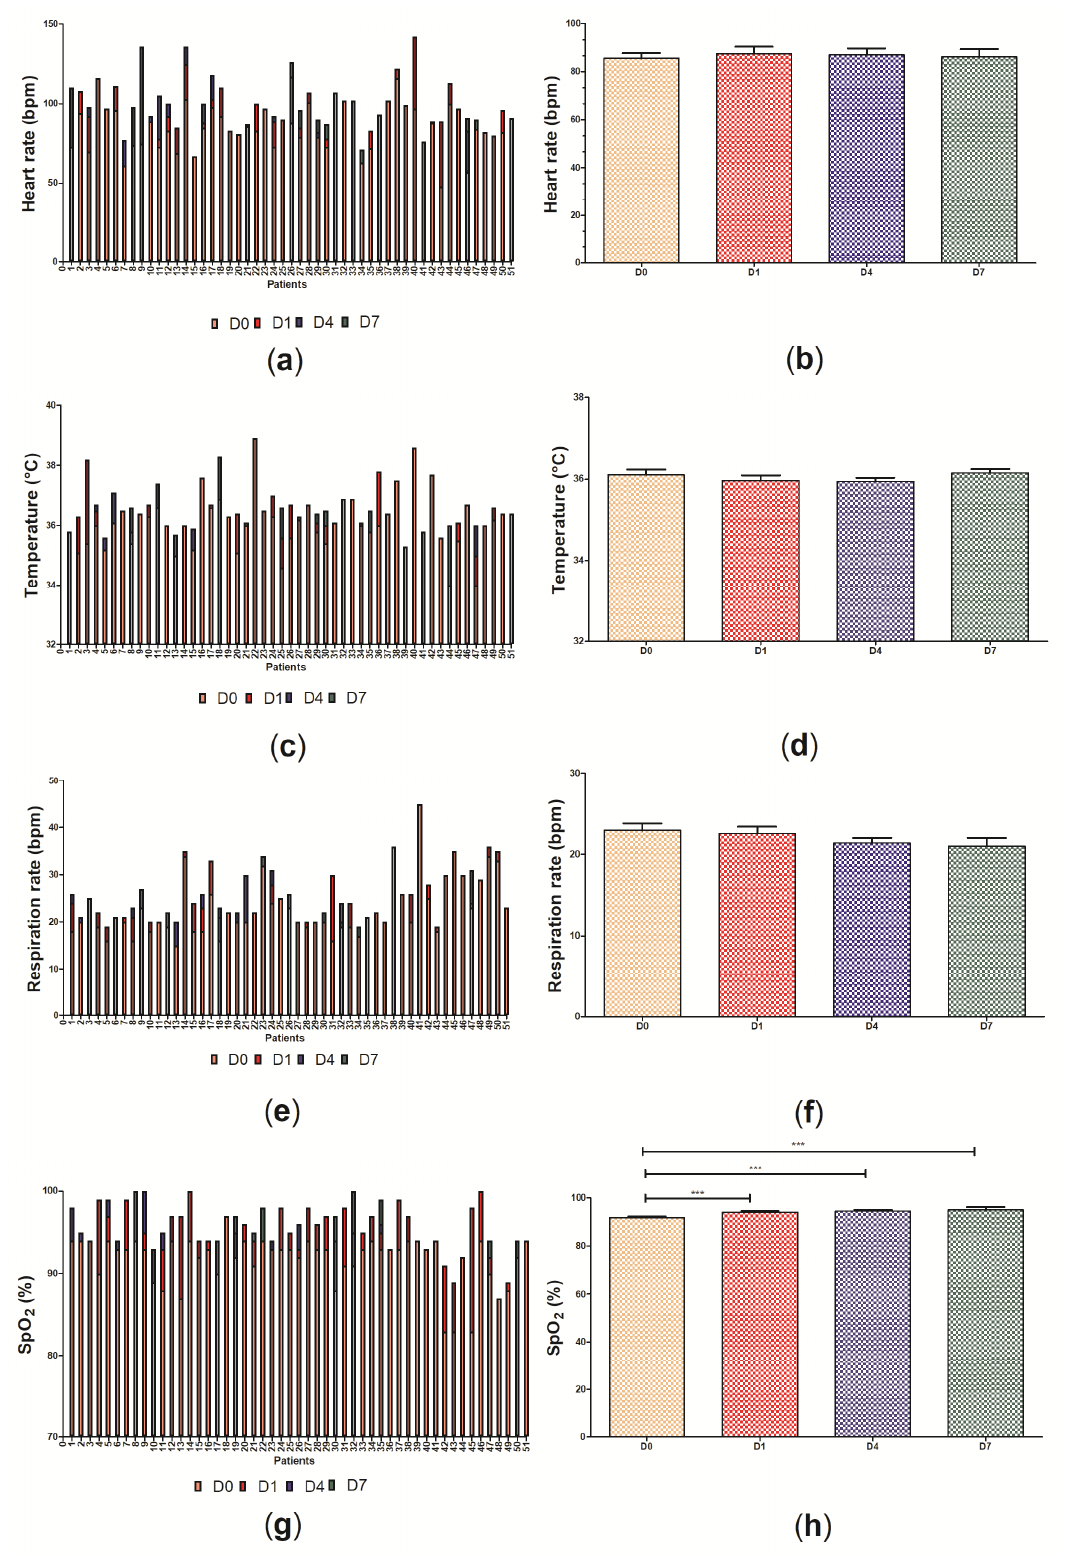
Figure 4. Study patients’ vital signs ( n = 51) considering heart rate ( a , b ), body temperature ( c , d ), respiratory rate ( e , f ), and pulse O 2 saturation ( g , h ).*** indicates the persistence of statistically significant differences after Bonferroni correction for multiple comparisons ( p < 0.05).